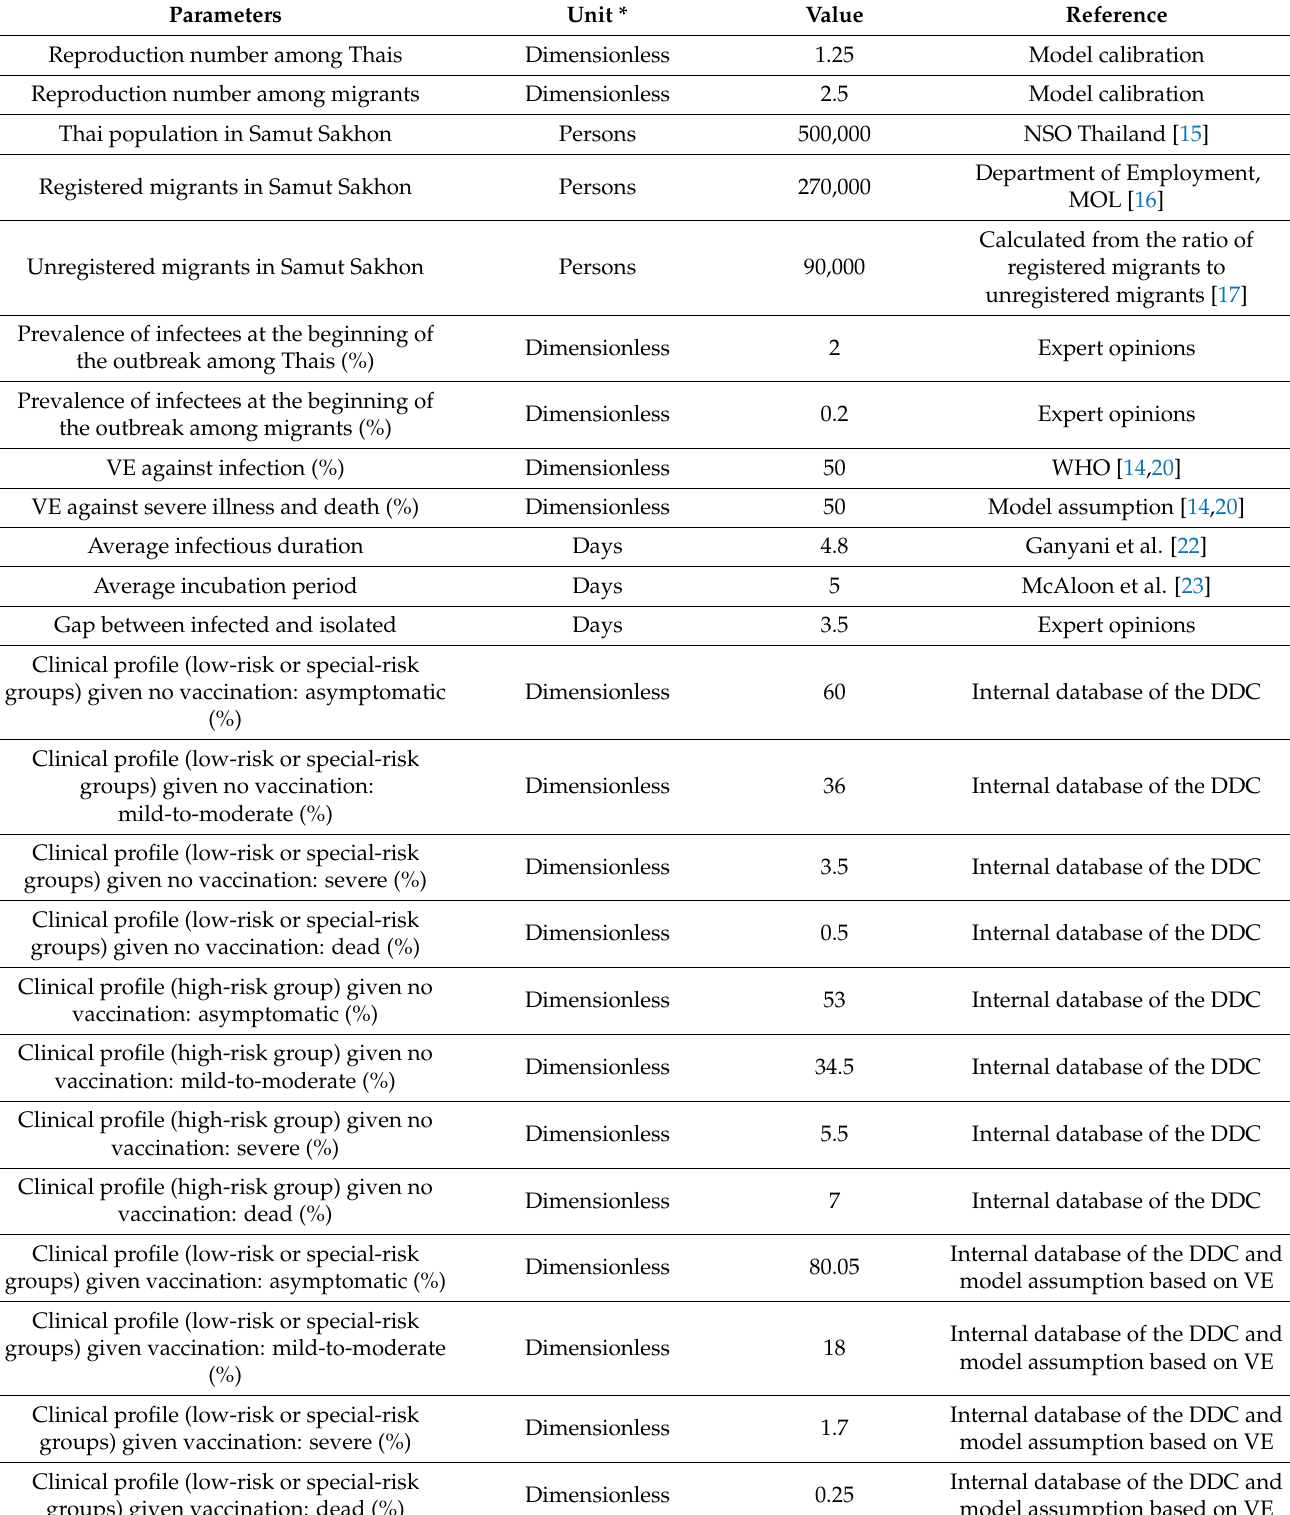
Table 4. List of key